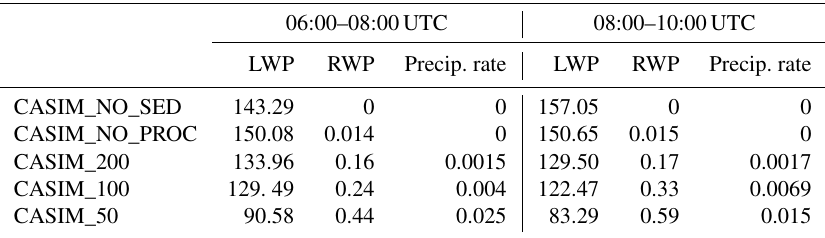
Figure 14. As in Fig. 5b but with results from CASIM_200 shown in red. Table 1. Table showing the mean values of liquid water path (LWP: gm − 2 ), rain water path (RWP: gm − 2 ), and surface precipitation rate (mmh − 1 ) calculated between 06:00–08:00 and 08:00–10:00UTC for five different simulations, listed in order of increasing rates of droplet sedimentation achieved by reducing droplet